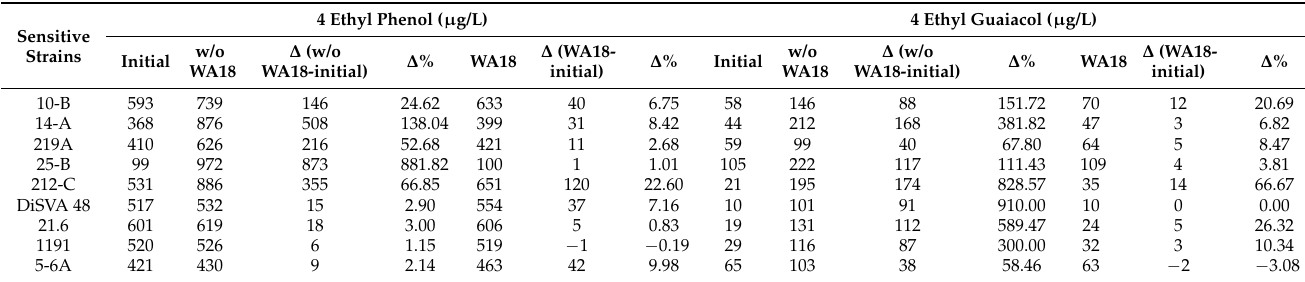
Table 5. Effect of WA18 mycocin using partially concentrated crude extract (AU 700 L − 1 in the wine samples) on ethyl phenol and ethyl guaiacol production by different B. bruxellensis strains after 60 days of incubation. Sensitive